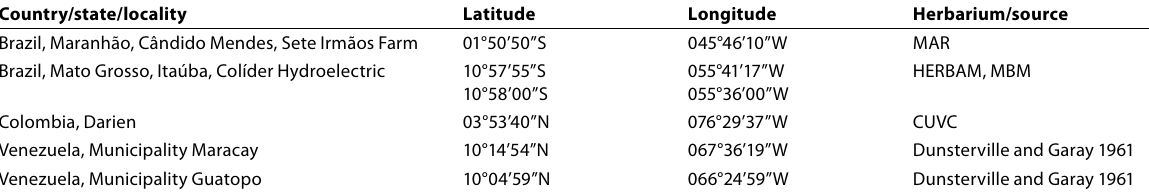
Table A1. Collection records of Maxillaria aureoglobula Christenson in South America used for producing of the distributional map. Her- baria acronyms follow Thiers